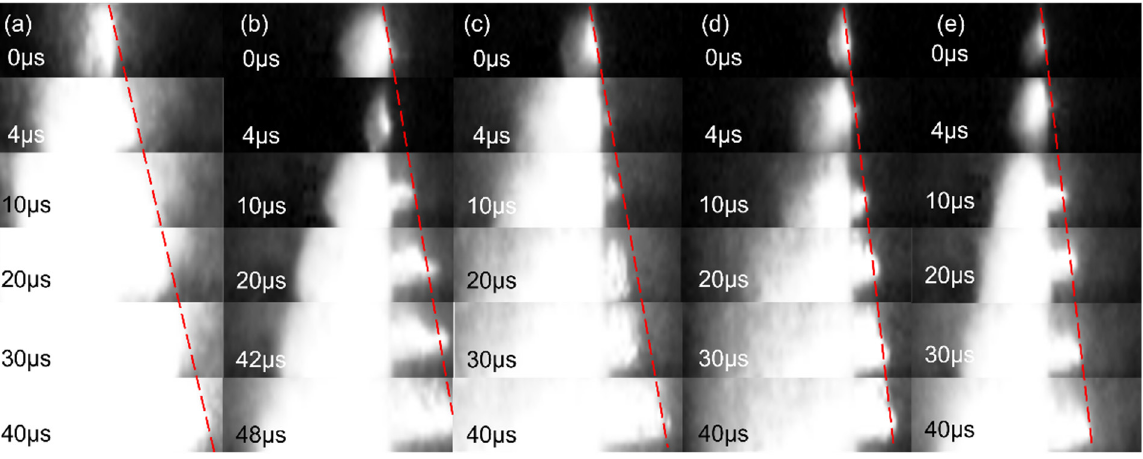
Figure 18. Flame propagation images of ( a ) Al–CuO, ( b ) Al–CuO/GO 0.5wt% , ( c ) Al–CuO/GO 1.0wt% , ( d ) Al–CuO/GO 3.0wt% , and ( e ) Al–CuO/GO 5.0wt% . The dotted line represents the burning end face.